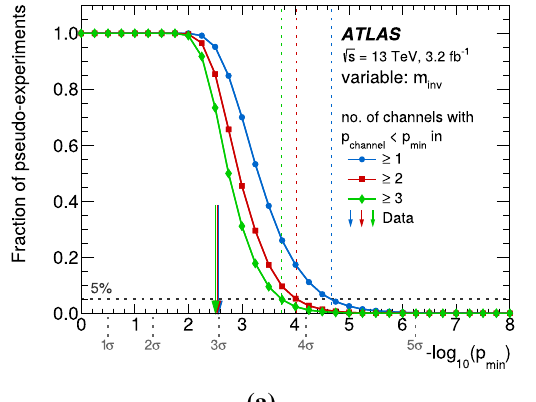
coloured arrows represent the three smallest p channel -values observed in data. Dashed lines are drawn at P exp , i = 5% and at the p min -values corresponding to 1 σ , 2 σ , 3 σ , 4 σ and 5 σ local significances. Details of the deviations can be found in Tables 4 and